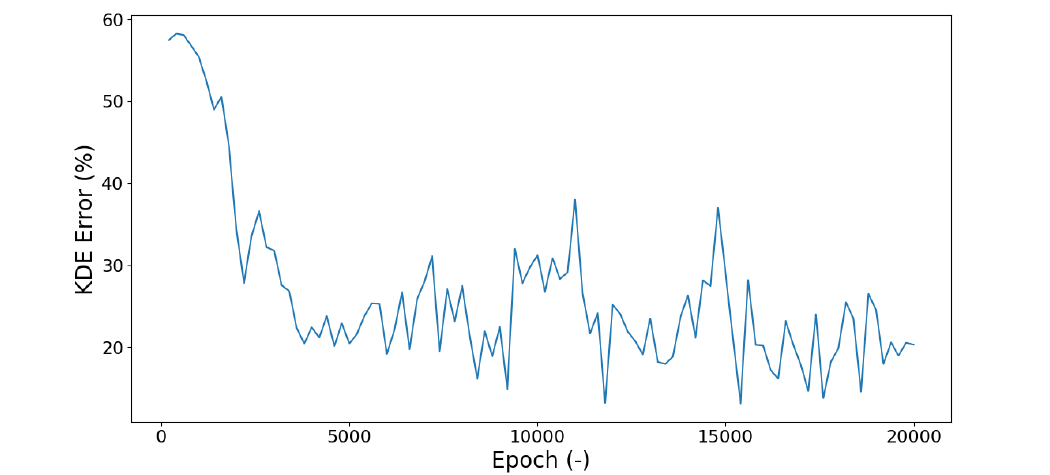
Figure 8. Development of the error of the output Kernel Density Estimation (KDE) compared to the input KDE over the course of